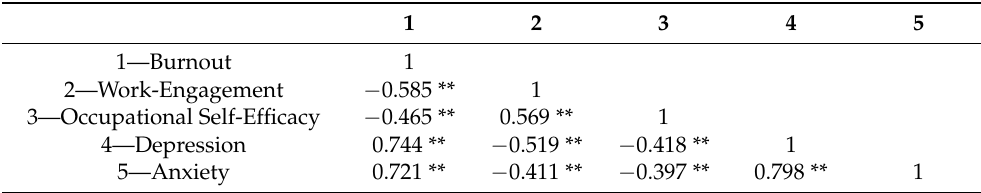
Table 5. Correlation matrix.